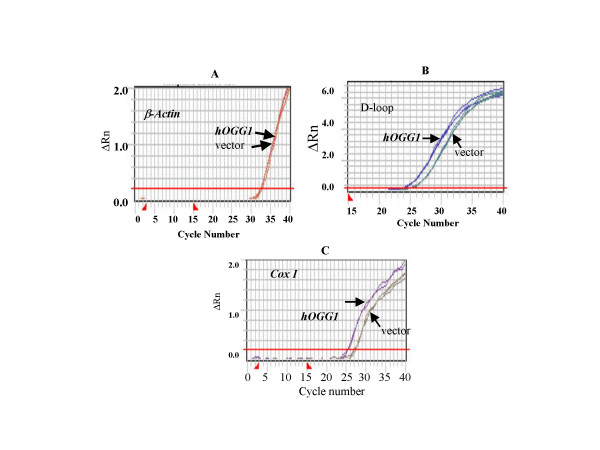
Real Time PCR Amplification Curves. Representative real-time PCR amplification curves generated for nuclear β-actin gene (Fig. 4A.), mitochondrial D-Loop (Fig. 4B.) and Cox I (Fig. 4C.) with and without wild type MTS-hOGG1 after treatment with 400 μM H2O2. Each experiment was performed in triplicate and is shown by overlapping amplification curves. ΔRn = (Rn+) - (Rn-), where Rn+ is the fluorescence emission intensity of reporter/emission intensity of quencher at any time point, and Rn- is the initial emission intensity of reporter/emission intensity of quencher in the same reaction vessel before PCR amplification is initiated.